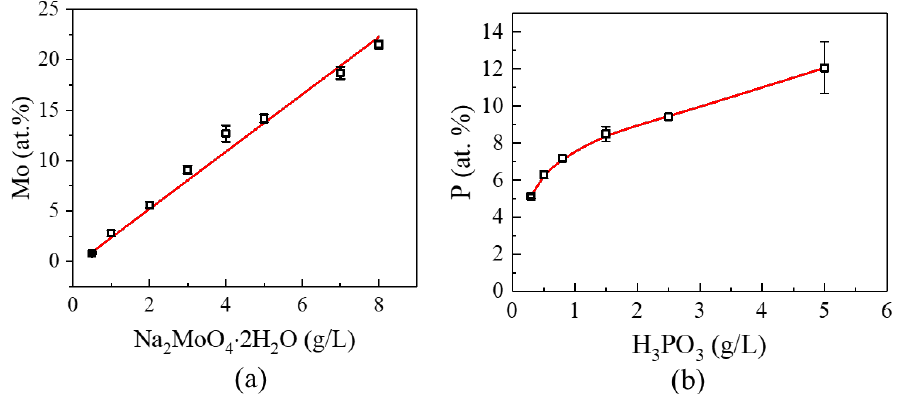
Figure 1. ( a ) Correlation between Mo content and concentration of sodium molybdate (Na 2 MoO 4 · H 2 O) ( b ) P content in Ni-P alloy vs. concentration of phosphorous acid (H 3 PO 3 ).